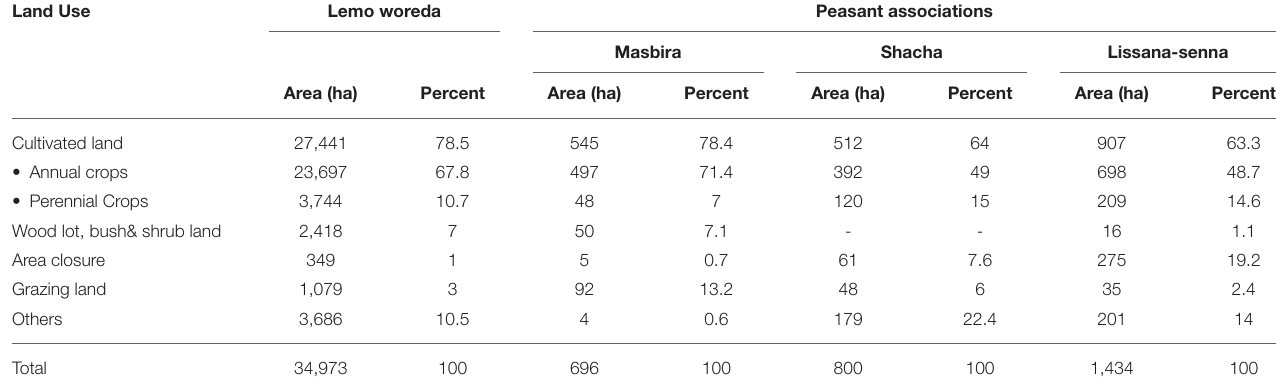
TABLE 2 | Land use